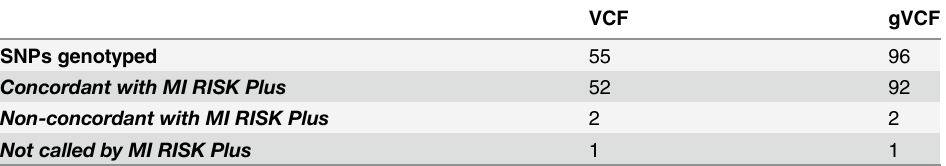
Table 1. Concordance of genotypes represented in VCF and gVCF files with those detected by the MI RISK Plus kit.